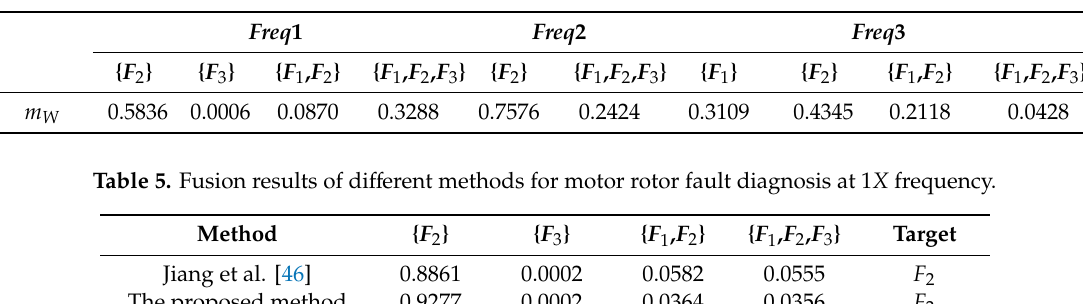
Table 4. The modified BPAs.